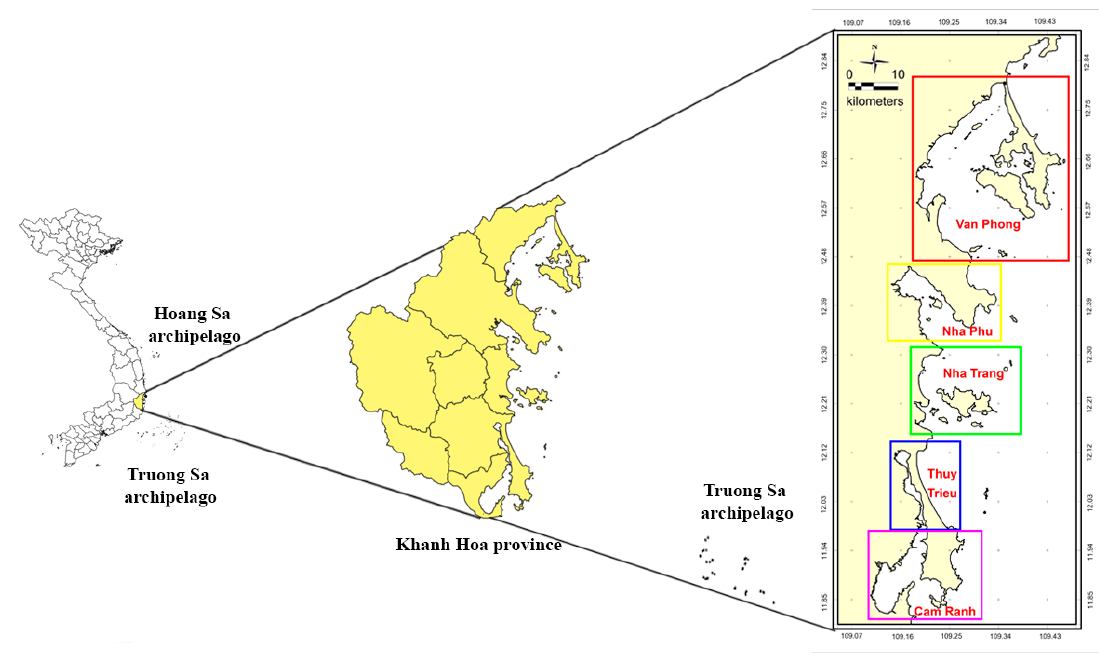
Figure 1. Study area with submerged aquatic vegetation (SAV) assessment sites.